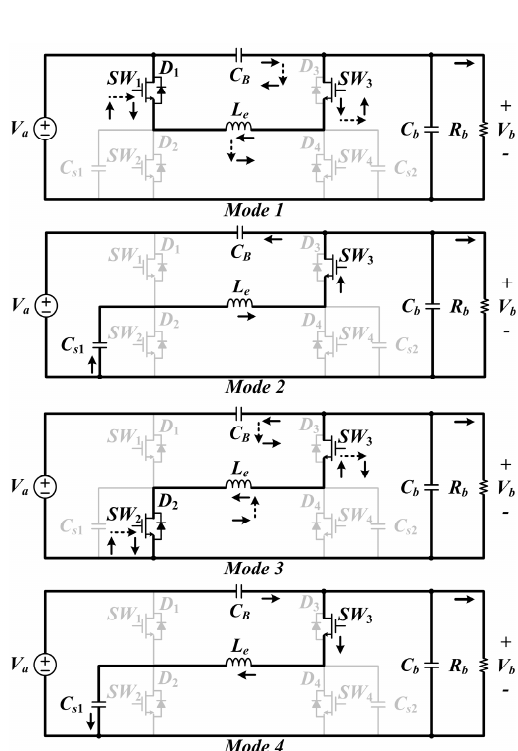
Figure 9. Circuit diagrams for the modes of operation for buck forward-conversion.